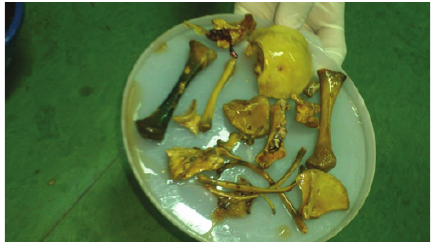
Figure 3: The evacuated fetal